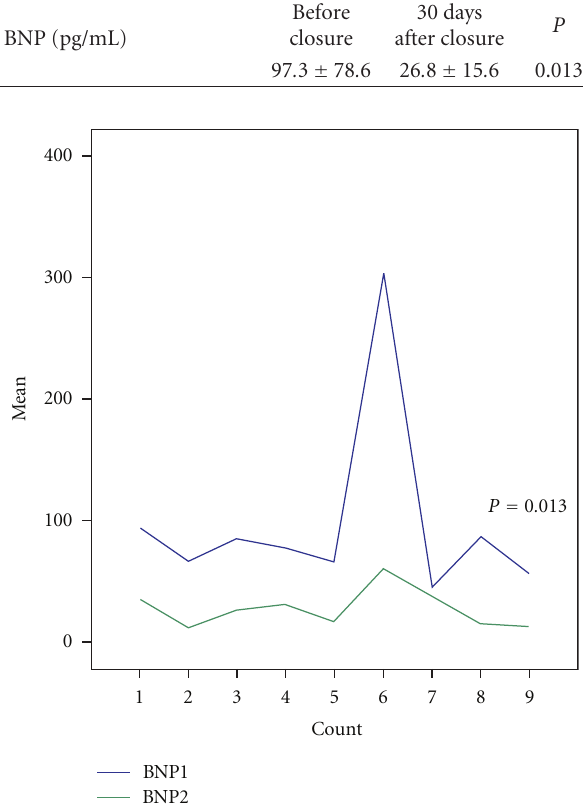
Figure 2: BNP levels before and after VSD